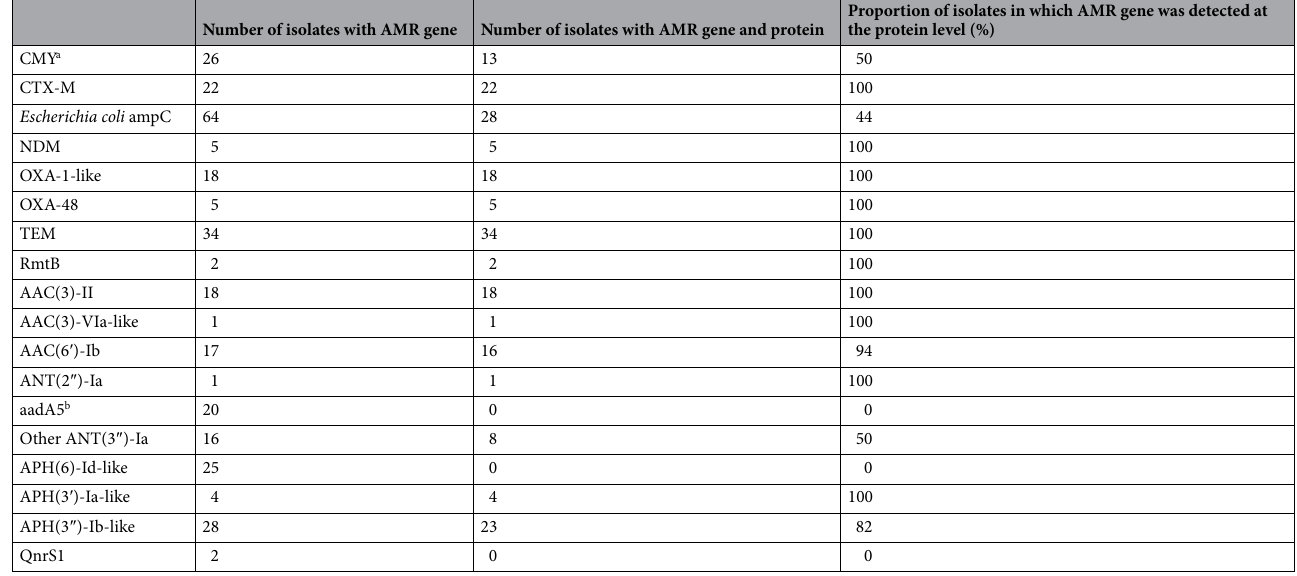
Table 1. Presence of genes and proteins of beta-lactamases, 16S ribosomal RNA methyltransferases, aminoglycoside modifying enzymes and quinolone resistance proteins in the 78 analysed E. coli . Origin